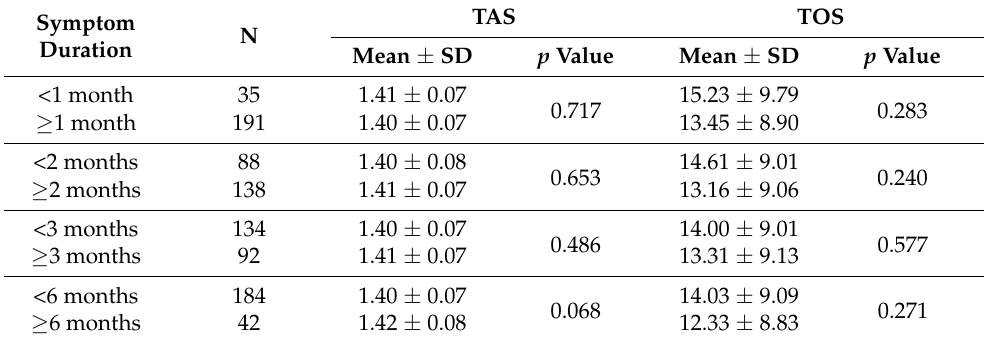
Table 2. Comparison of TAS/TOS among groups classified according to duration of